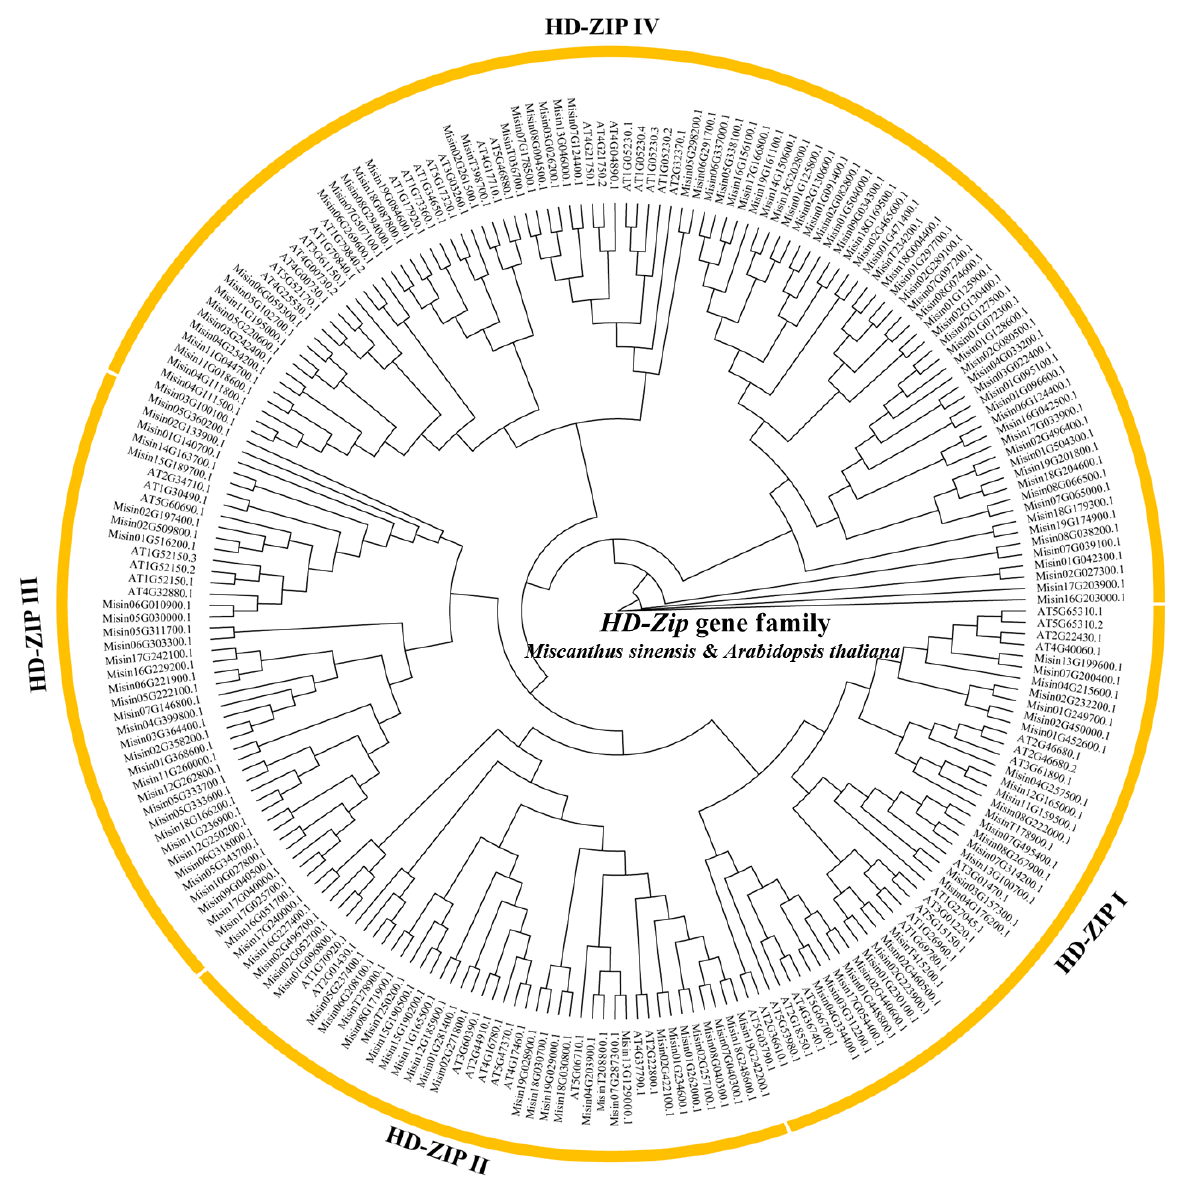
Figure 1. Unrooted phylogenetic tree illustrating links between the 169 HD-Zip proteins in